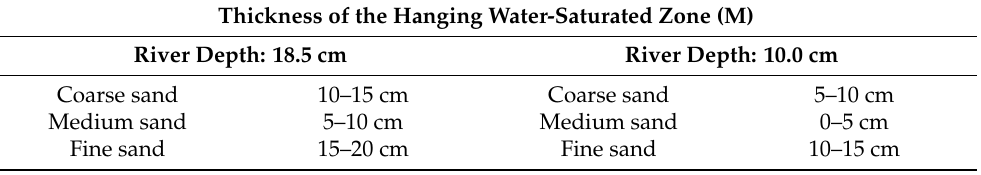
Figure 14. Schematic diagram of river and groundwater evolution under different particle sizes in aqueous media.